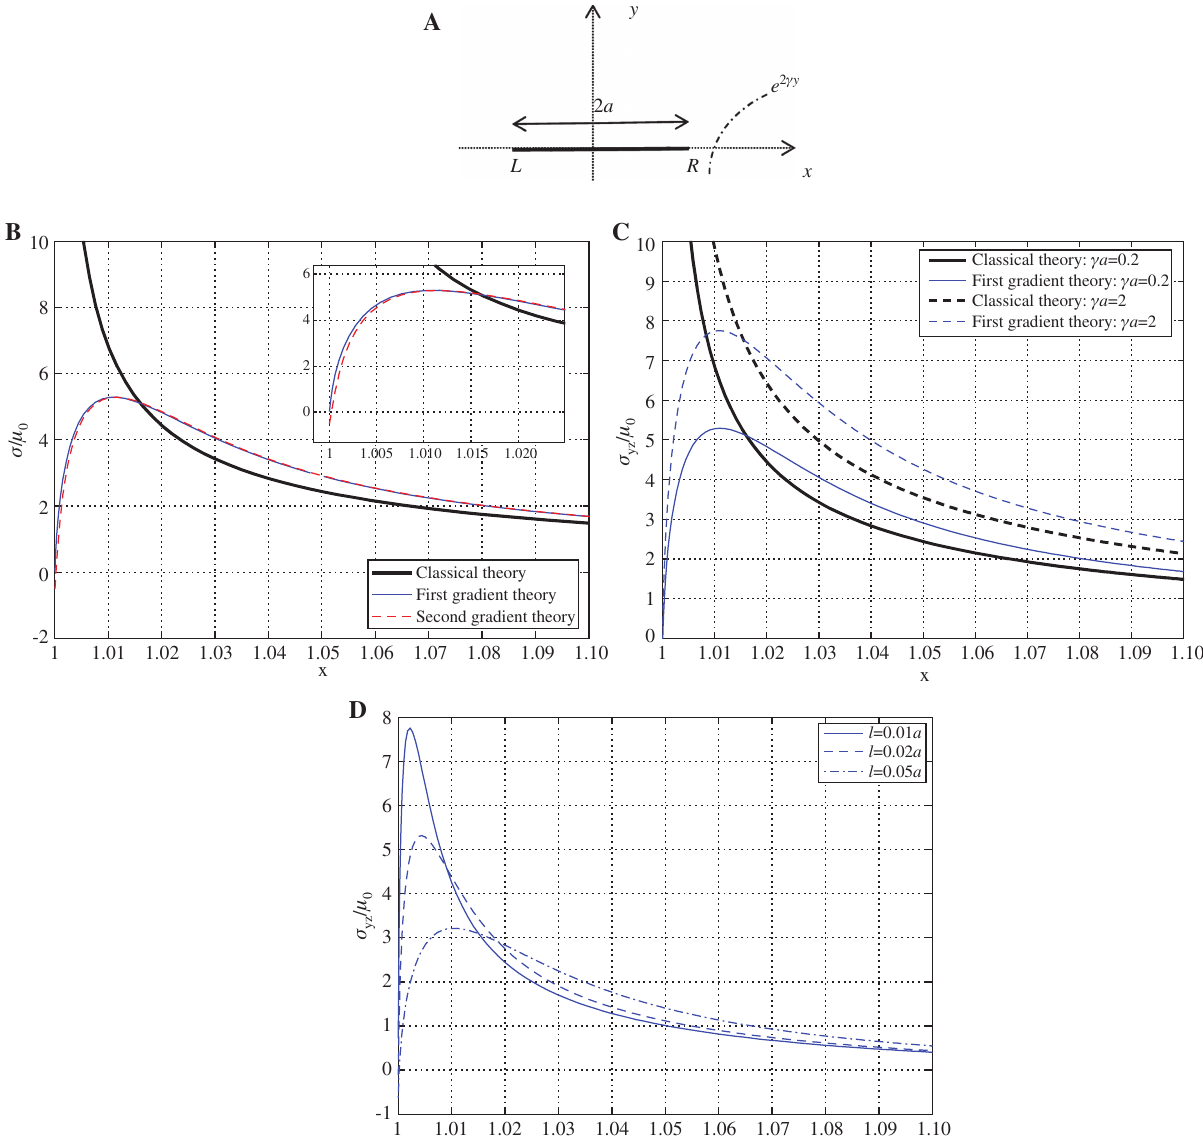
Figure 1 (A) Geometry of the functionally graded medium with a horizontal crack. (B) Normalized stress distribution for a horizontal crack in a graded plane ( γ a = 0.2 , l = 0.01 a , l ′ = l /5). (C) Normalized stress distribution for a horizontal crack in a graded plane for different gradation parameter: γ a = 0.2 and γ a = 2 ( l = 0.01 a ). (D) Normalized stress distribution for a horizontal crack in a graded plane ( γ a = 2) in first gradient elasticity: l = (0.01 , 0.02, 0.05) a